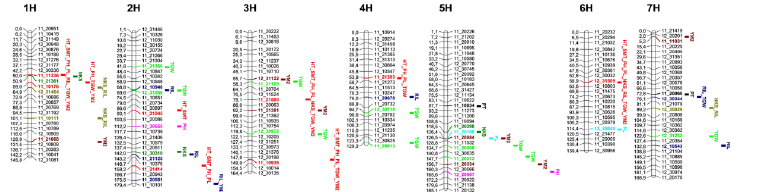
Fig 5. Locations of significant MTAs on seven barley chromosomes. SNPs and abbreviations of traits are given on right, and positions of SNPs are shown in cM on the left. HT–days to heading, SMT–days to seed maturation, PH– plant height, PL–peduncle length, PT–productive tillering, SL–spike length, NKS–number of kernels per spike, RIL– rachis internode length, TGW–thousand grain weight, YM2 –yield per square